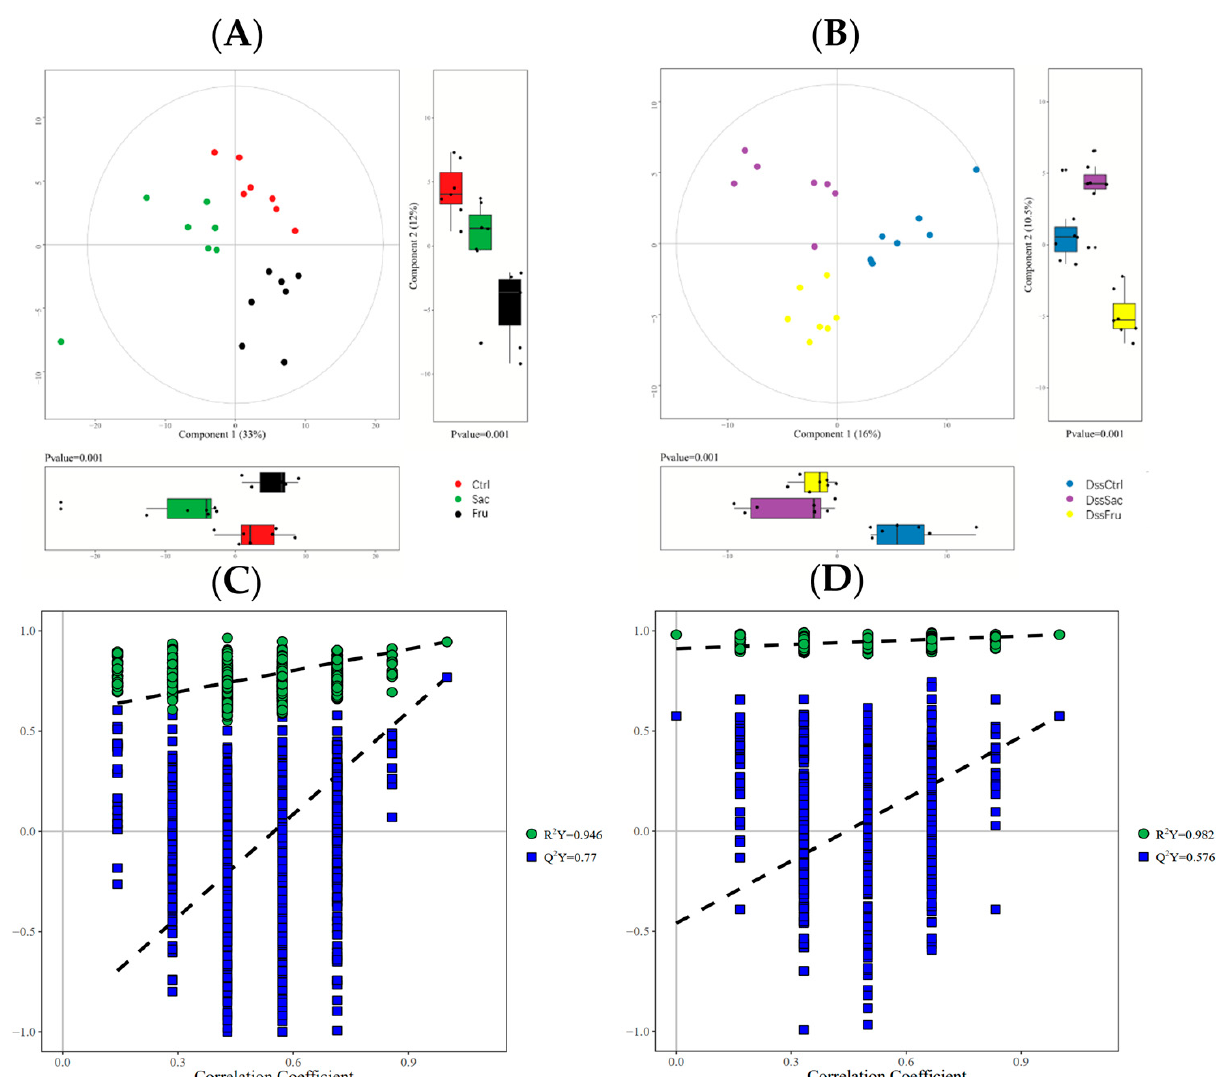
Figure 5. Metabolic profiles of sucrose and fructose in the colon contents of rats. ( A , B ) PCA score of colon contents in different groups; ( C , D ) OPLSA-DA permutation: C1. Sac vs. Fru; C2. DssSac vs. DssFru.